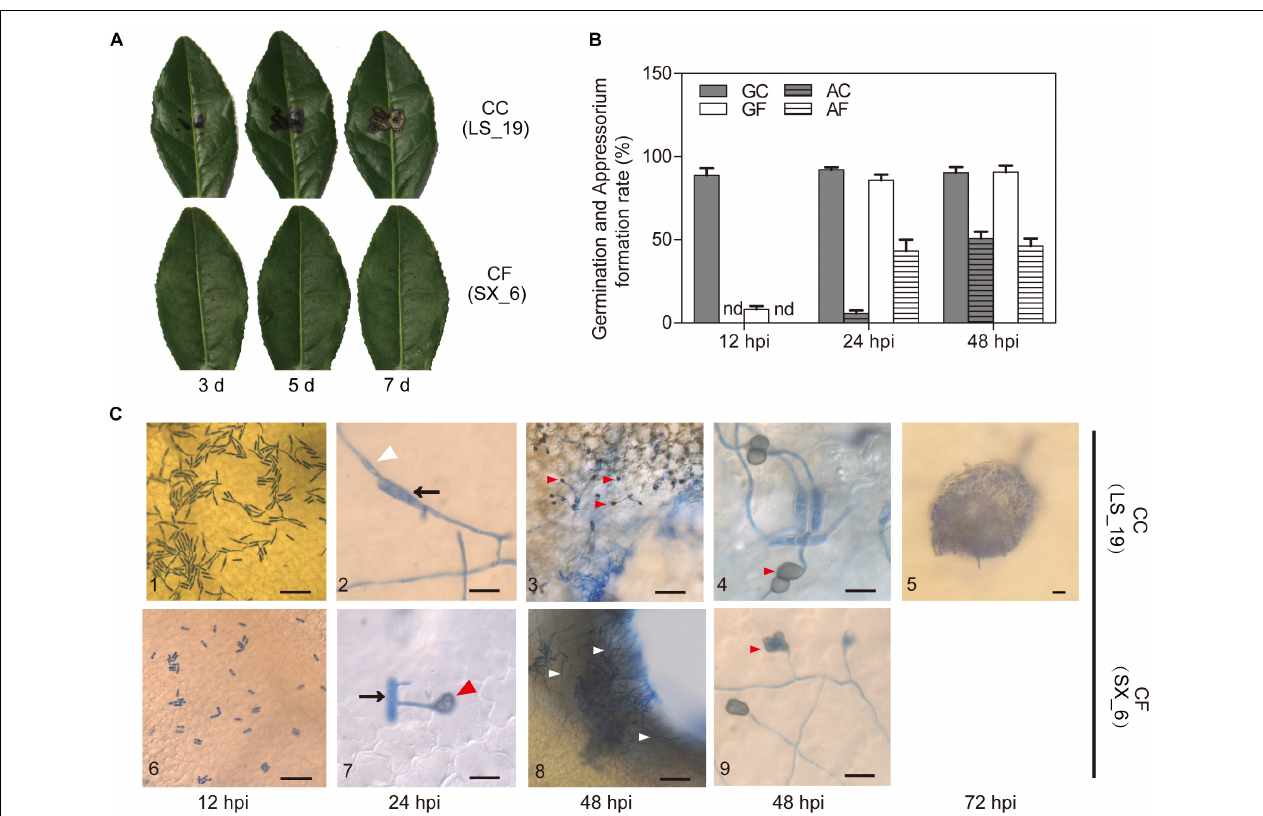
FIGURE 2 | Pathogenicity and inoculation. (A) Pathogenicity tests of C. camelliae (strain LS_19) and C. fructicola (strain SX_6) on tea plant leaves after 3, 5, and 7 days. (B) Quantification of germinated conidia and appressoria per 100 conidia. GC, Germination of C. camelliae . AC, Appressoria of C. camelliae . GF, Germination of C. fructicola . AF, Appressoria of C. fructicola . nd, not detectable. The error bars represent the SEM; n = 100. (C) Microscopic examination of fungi stained with aniline blue. C3 and C8 show the wound areas; C4 and C9 show the nonwounded segment. C10 shows an acervul us at 72 hpi. The arrows indicate conidia, the white triangles indicate hyphae, and the red triangles indicate appressoria. Scale bar = 50 µ m in C1, C3, C5, C6, and C8; scale bar = 10 µ m in C2, C4, C7, and